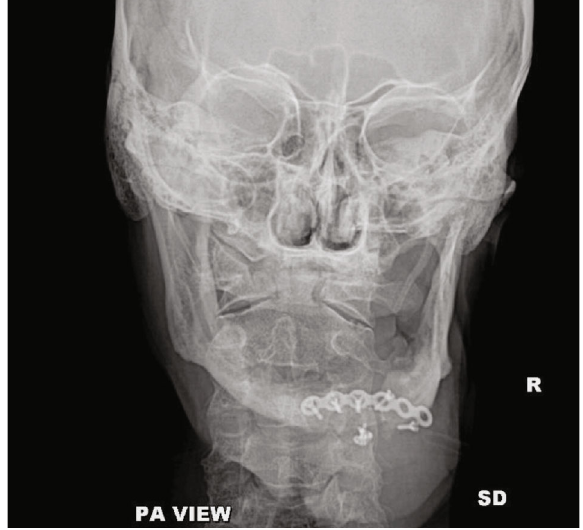
Figure 8: CT scan after hardware